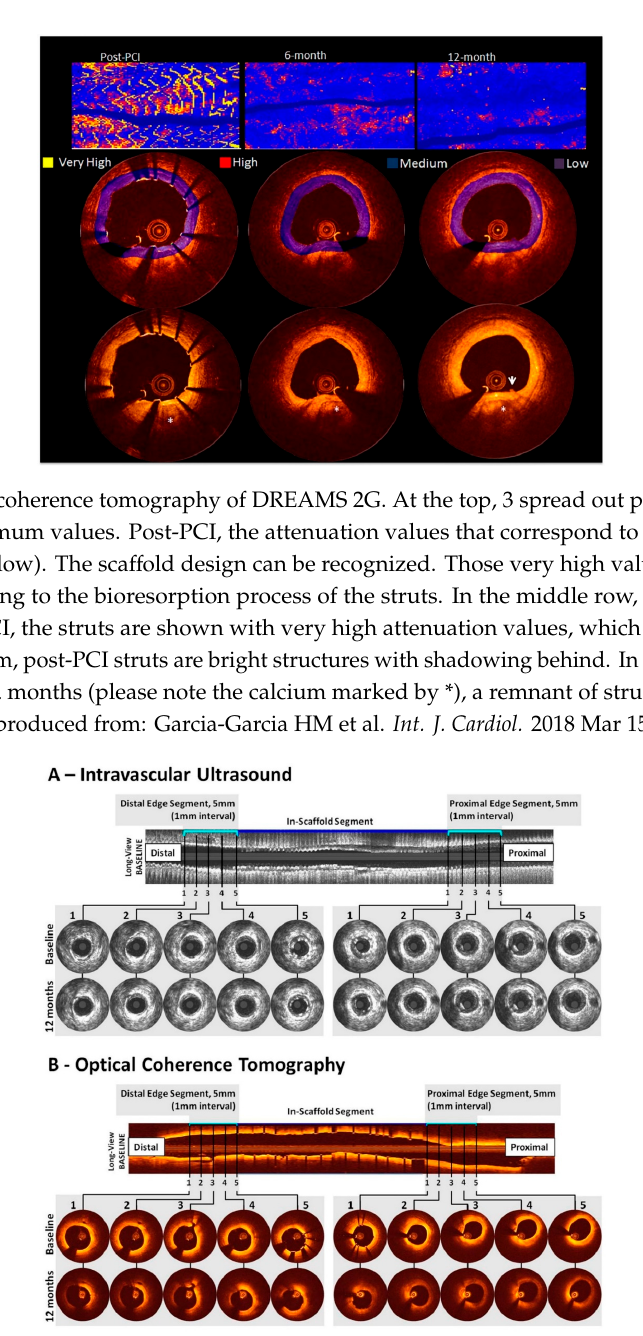
Figure 3. Magmaris edge vascular response segment and frame level analysis panel. Intravascular Ultrasound ( A ); and Optical Coherence Tomography ( B ), (Reproduced from: Hideo-Kajita A et al. Cardiovasc Revasc Med. 2019 May, 20(5), 392–398.)